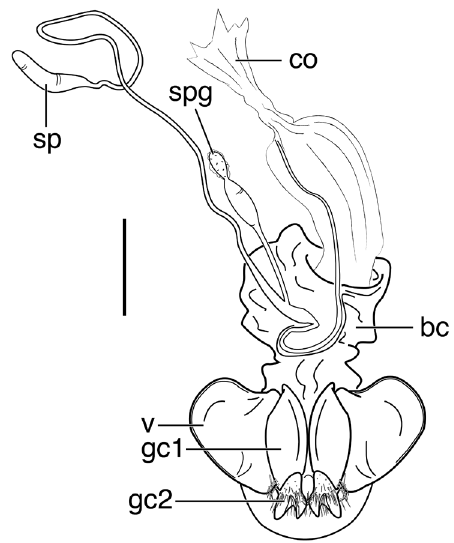
Figure 64. Line drawing of female reproductive tract of Stenomorphus californicus rufipes LeConte, ventral aspect. Legend: bc bursa copulatrix co common oviduct gc1 gonocoxite 1 gc2 gonocoxite 2 sp spermatheca spg spermathecal gland v valvifer. Scale bar 1 mm.